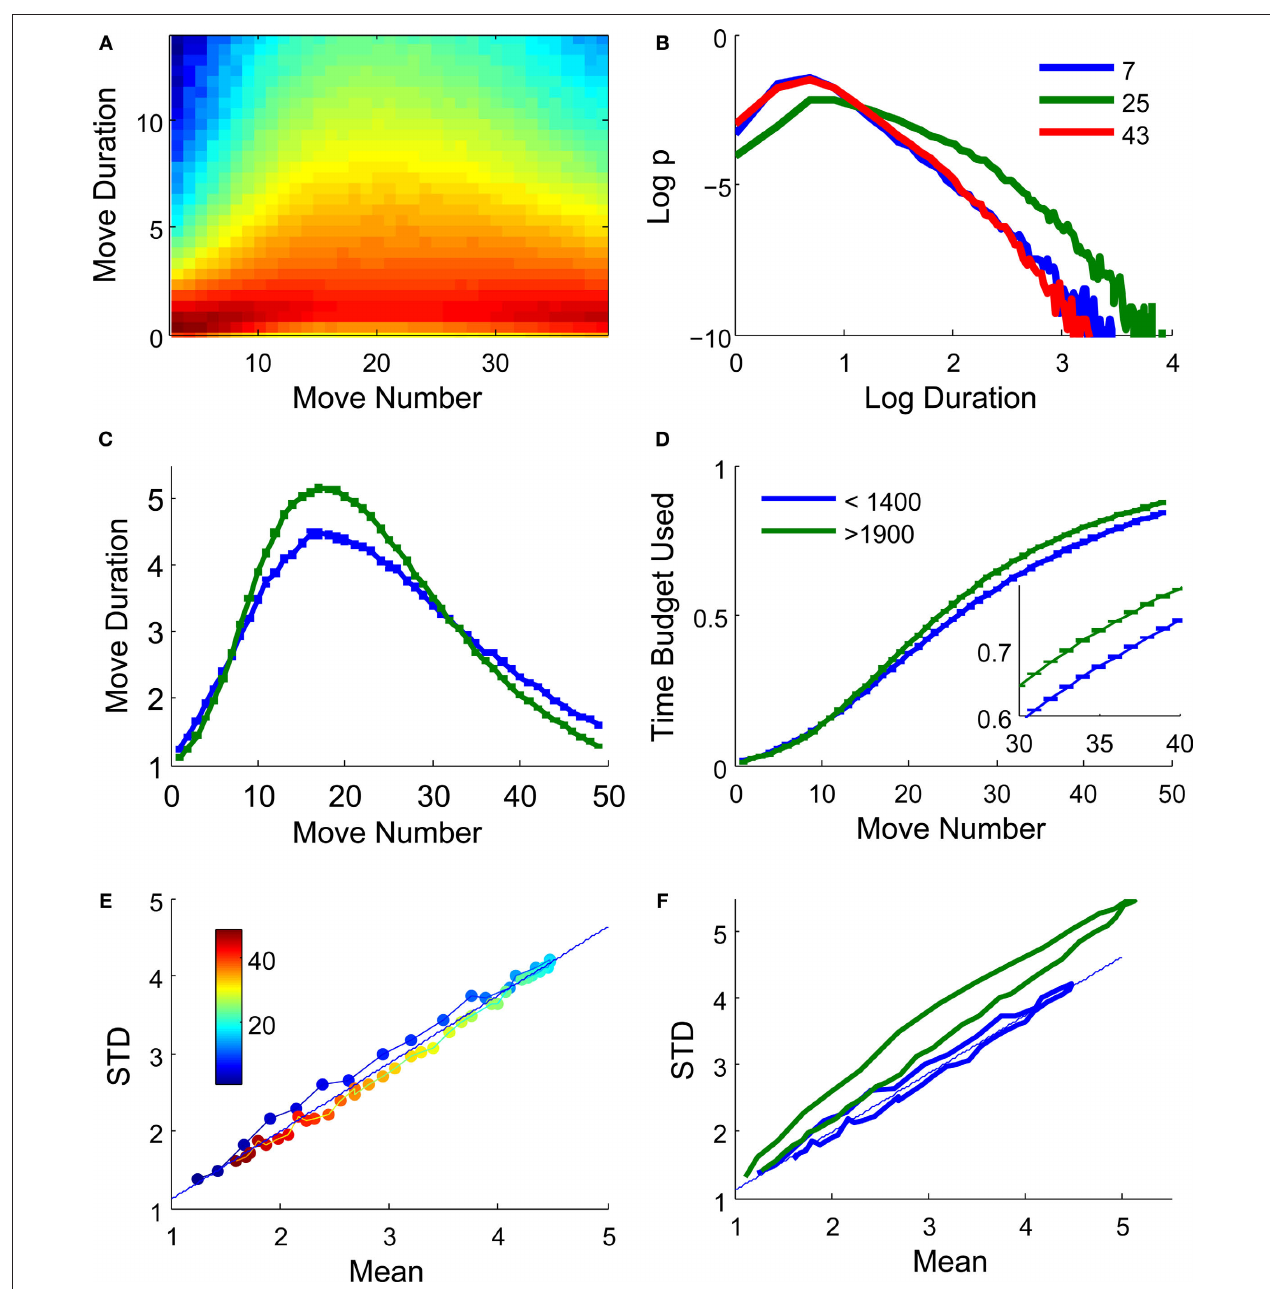
the inset shows a zoom of the figure for move numbers between 30 and 40. Note that within this range, higher rated players have used a greater fraction of their budget. (e) Standard deviation of the distribution shows a linear relation with the mean. The image shows the mean and SD for all move numbers (color coded) and the regression line. The lines represent the trajectory of the game, connecting sequential moves. (F) Same as (e) , comparing mean and SD for all moves for high rated (green) and low rated (blue)